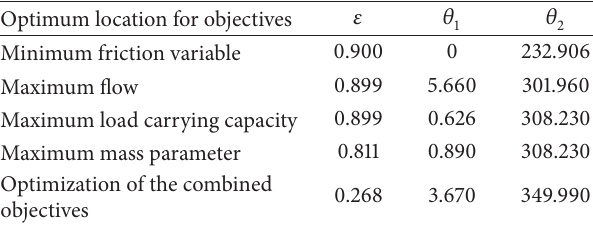
Table 6: Optimum location considering different